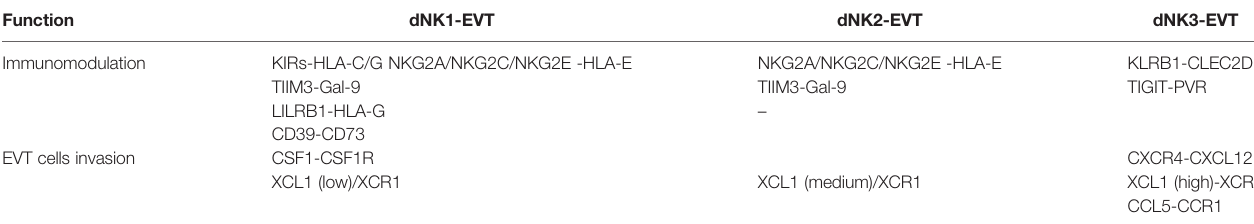
TABLE 2 | The surface or soluble molecules from dNK cells subsets and their receptors/ligands on EVT.